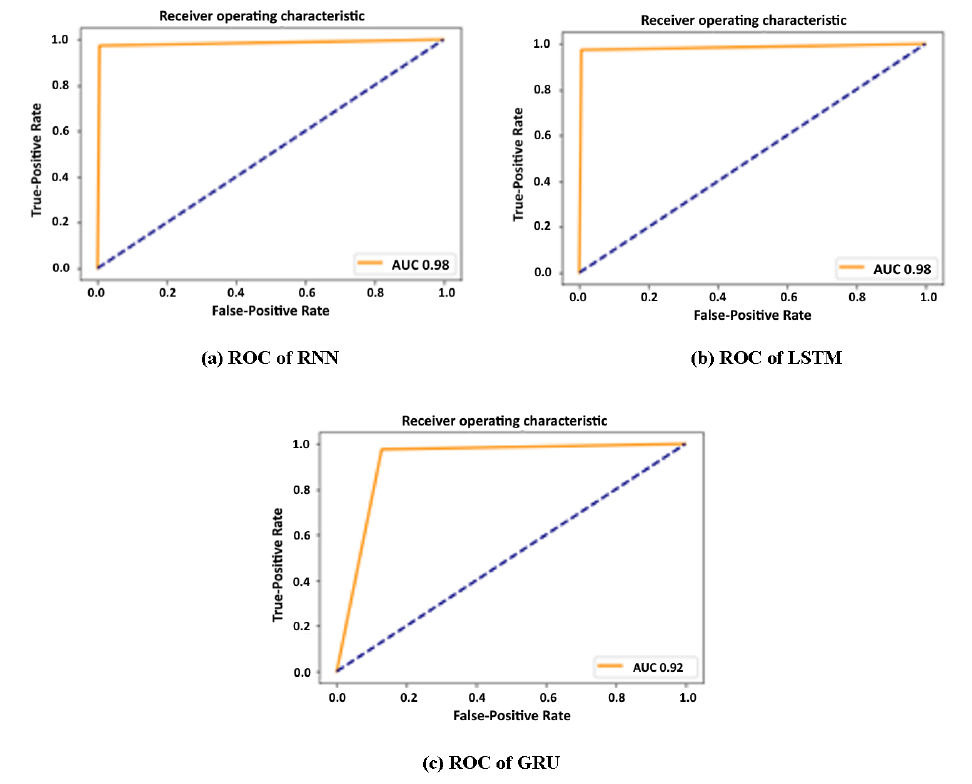
Figure 5. ACU–ROC curves of RNN, LSTM, and